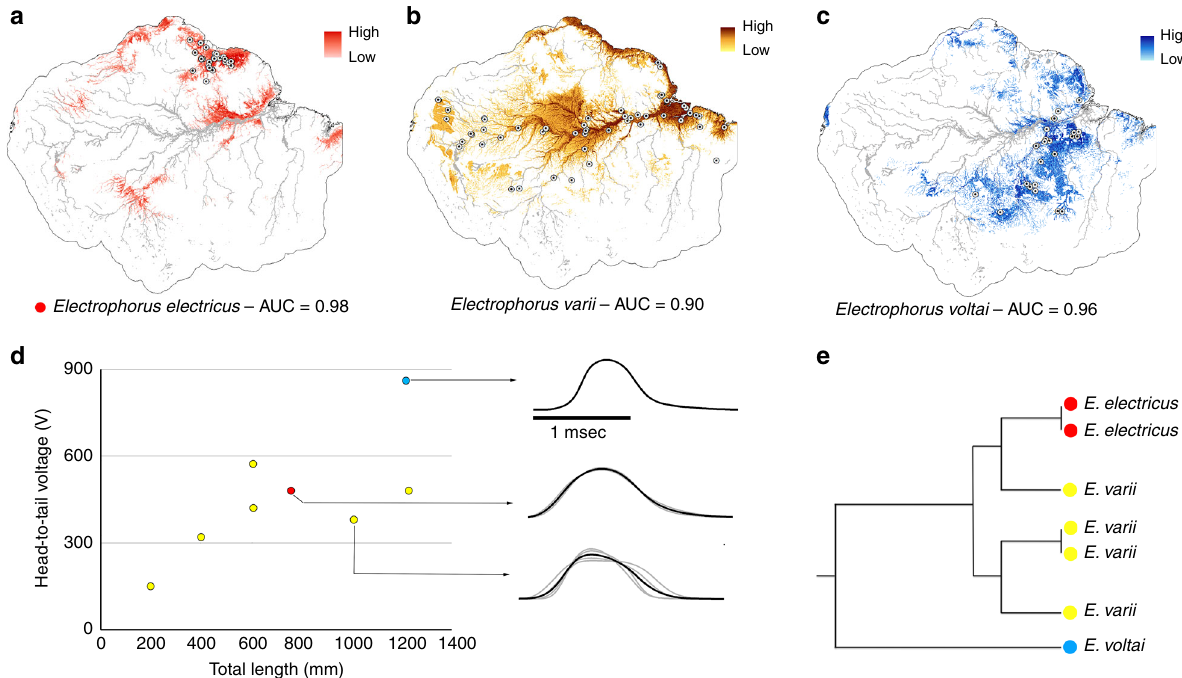
Fig. 4 Ecological Niche Model and electric organ discharges for species of Electrophorus . Species niche models generated by MaxEnt for Greater Amazonia: a Electrophorus electricus (red); b E . varii (yellow); and c E . voltai (blue). d Measurements of voltage of high-voltage EODs, low-voltage EODs waveforms from Sach ’ s organ, and posterior one-third of Hunter's organ (grey lines = individually recorded fi sh, black lines = averaged waveform for each species). e Nearest-neighbor hierarchical clustering of prominent time-frequency features of the low-voltage Sach ’ s organ EOD from seven individuals of